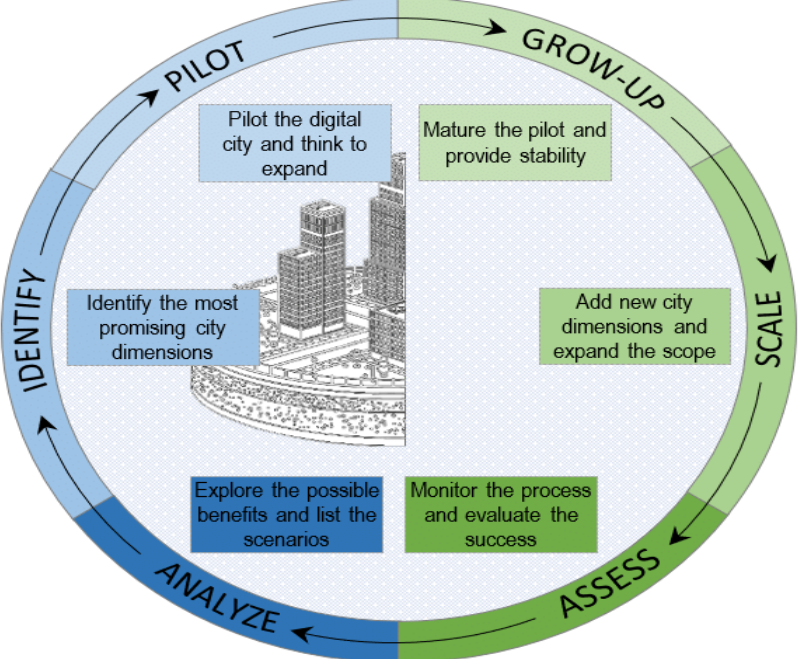
Figure 3. Digital transition and performance assessment of smart cities. Reprinted/adapted with permission from Ref [23], 2019, Petrova-Antonova A., Dessislava M. and Ilieva, S. Unlike B. Cohen, evolutionary direction designed by Eggers D. and Skowron J. in 2016 [23,24] split it into infrastructure and human-centered design with digitalization and data technologies united together for the best synergy in the decision-making process (Figure 4).